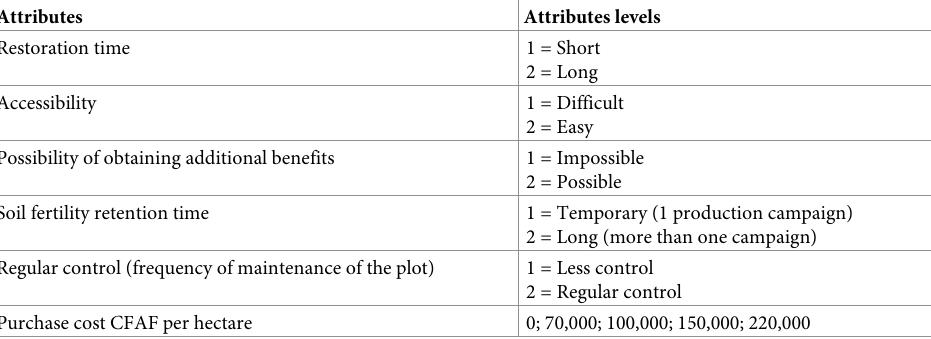
Table 2. Attributes and associated attribute